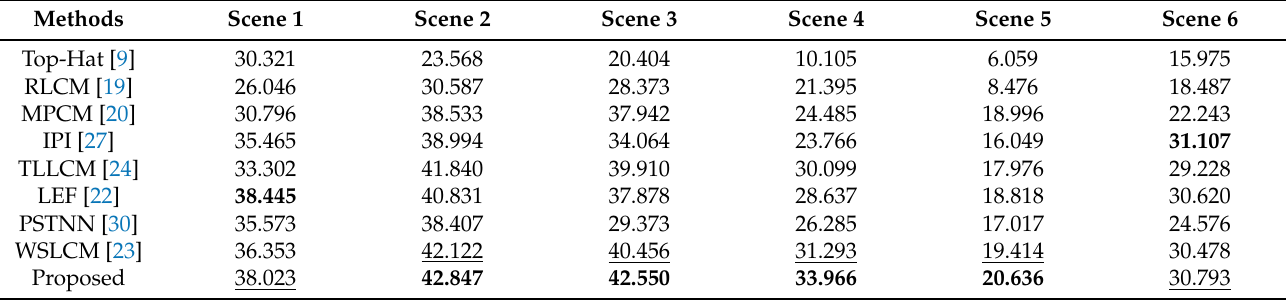
Table 3. Average SNRG values of different methods in six real